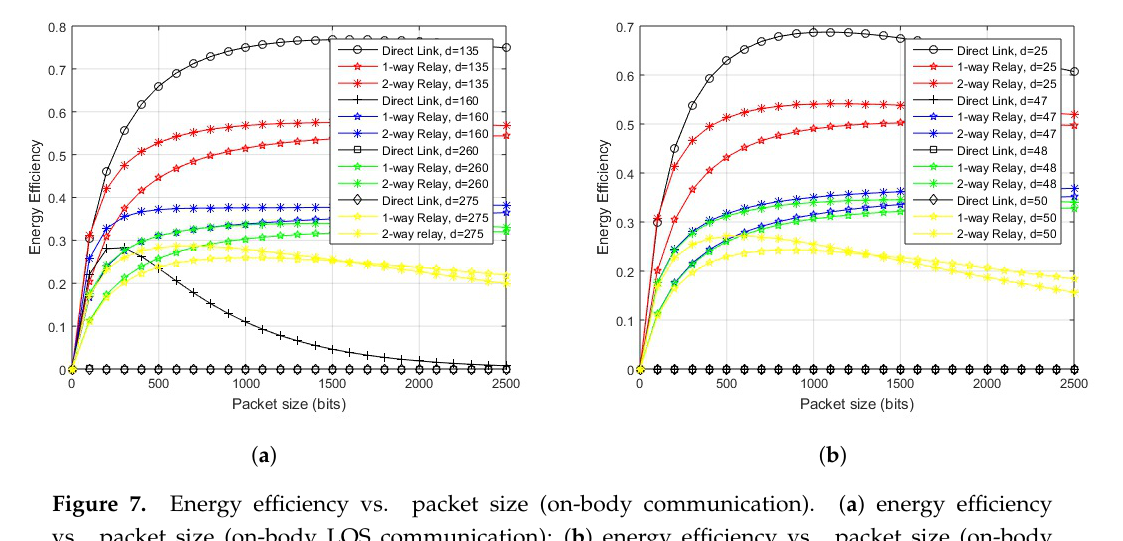
Figure 7. Energy efficiency vs. packet size (on-body communication). ( a ) energy efficiency vs. packet size (on-body LOS communication); ( b ) energy efficiency vs. packet size (on-body NLOS